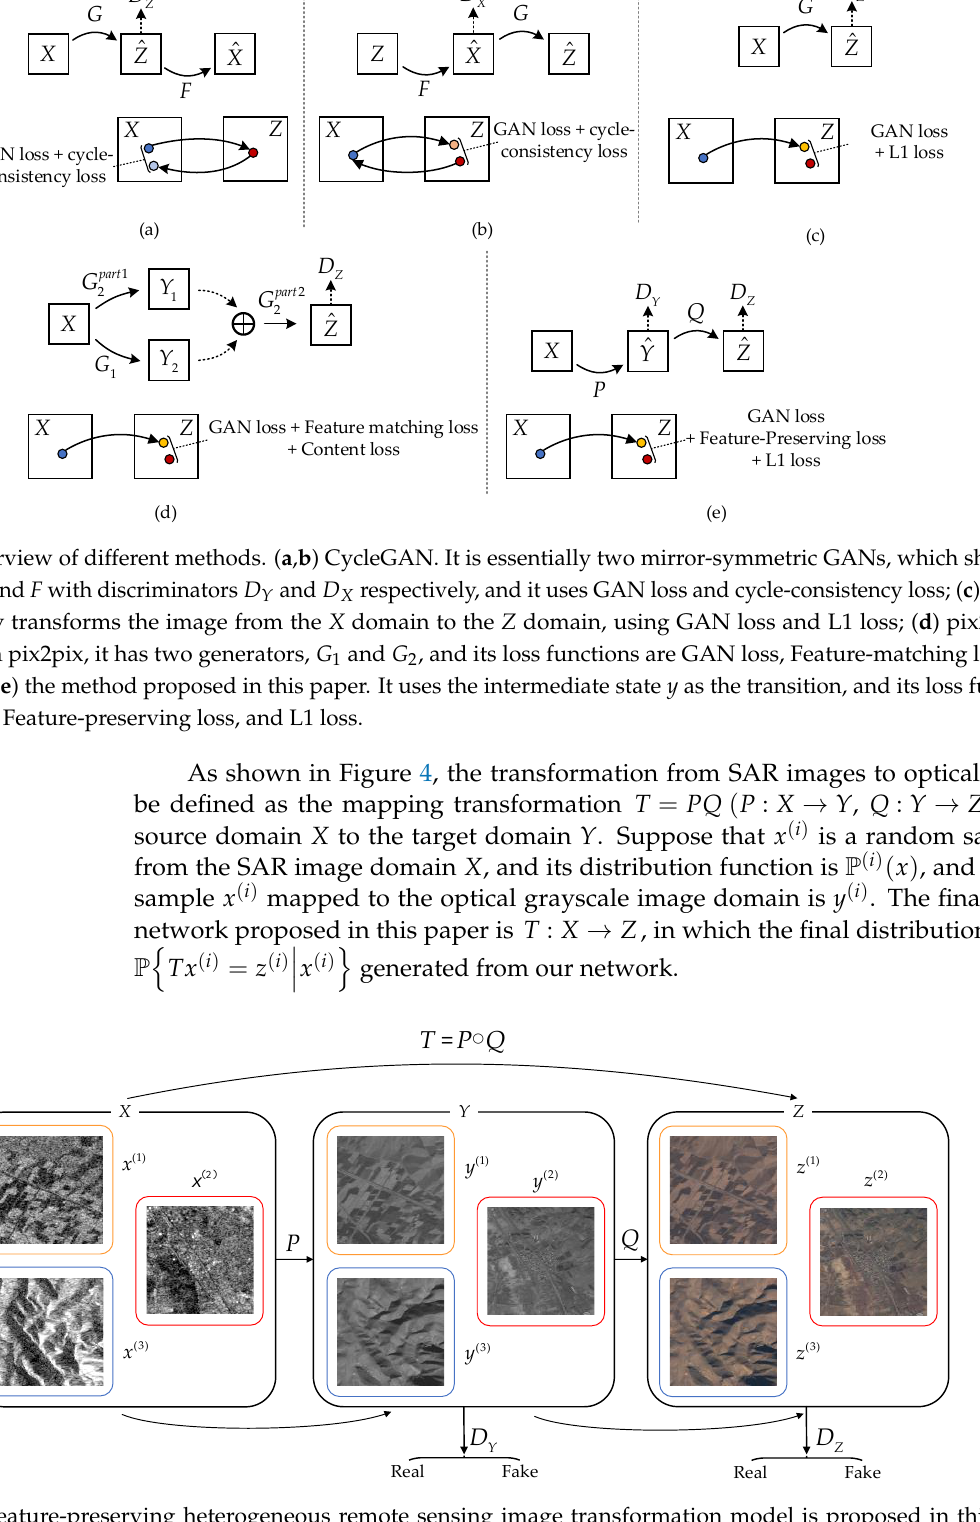
Figure 4. A feature-preserving heterogeneous remote sensing image transformation model is proposed in this paper. Let X , Y , and Z denote the SAR image domain, intermediate optical grayscale image domain, and optical color image domain, respectively, and x ( i ) ∈ X , y ( i ) ∈ Y and z ( i ) ∈ Z denote the dataset samples of the corresponding image domain ( i = 1,2, · · · , N , N denotes the total sample number of the data set).